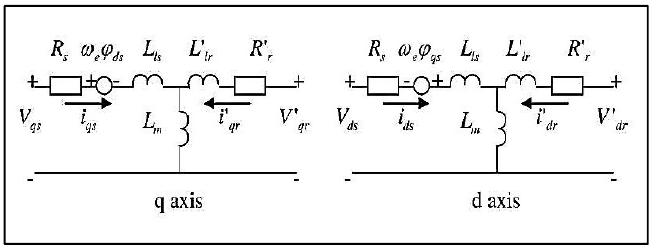
Figure 5. Circuit equivalent model of the squirrel cage induction generator (flux and current model (FCM)).